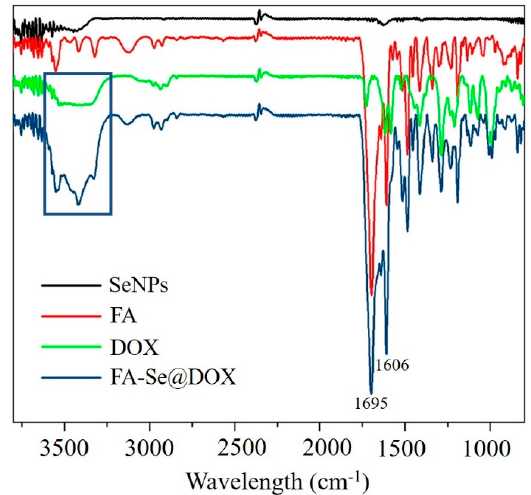
Figure 2. Fourier transform infrared spectroscopy (FTIR) spectra of SeNPs, FA, DOX, and FA-